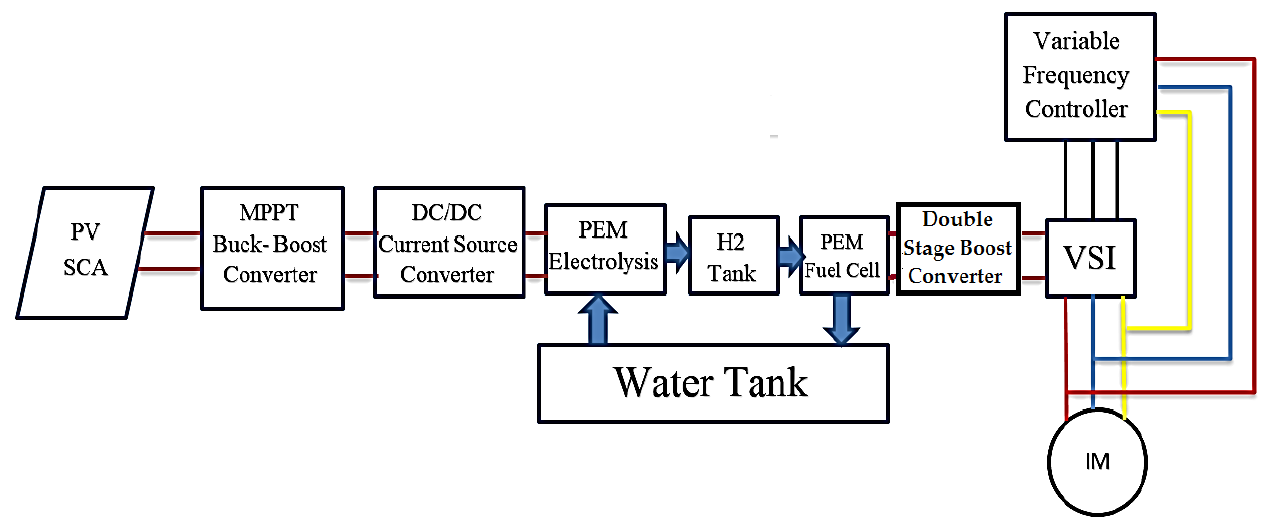
Figure 2. Proposed setup.